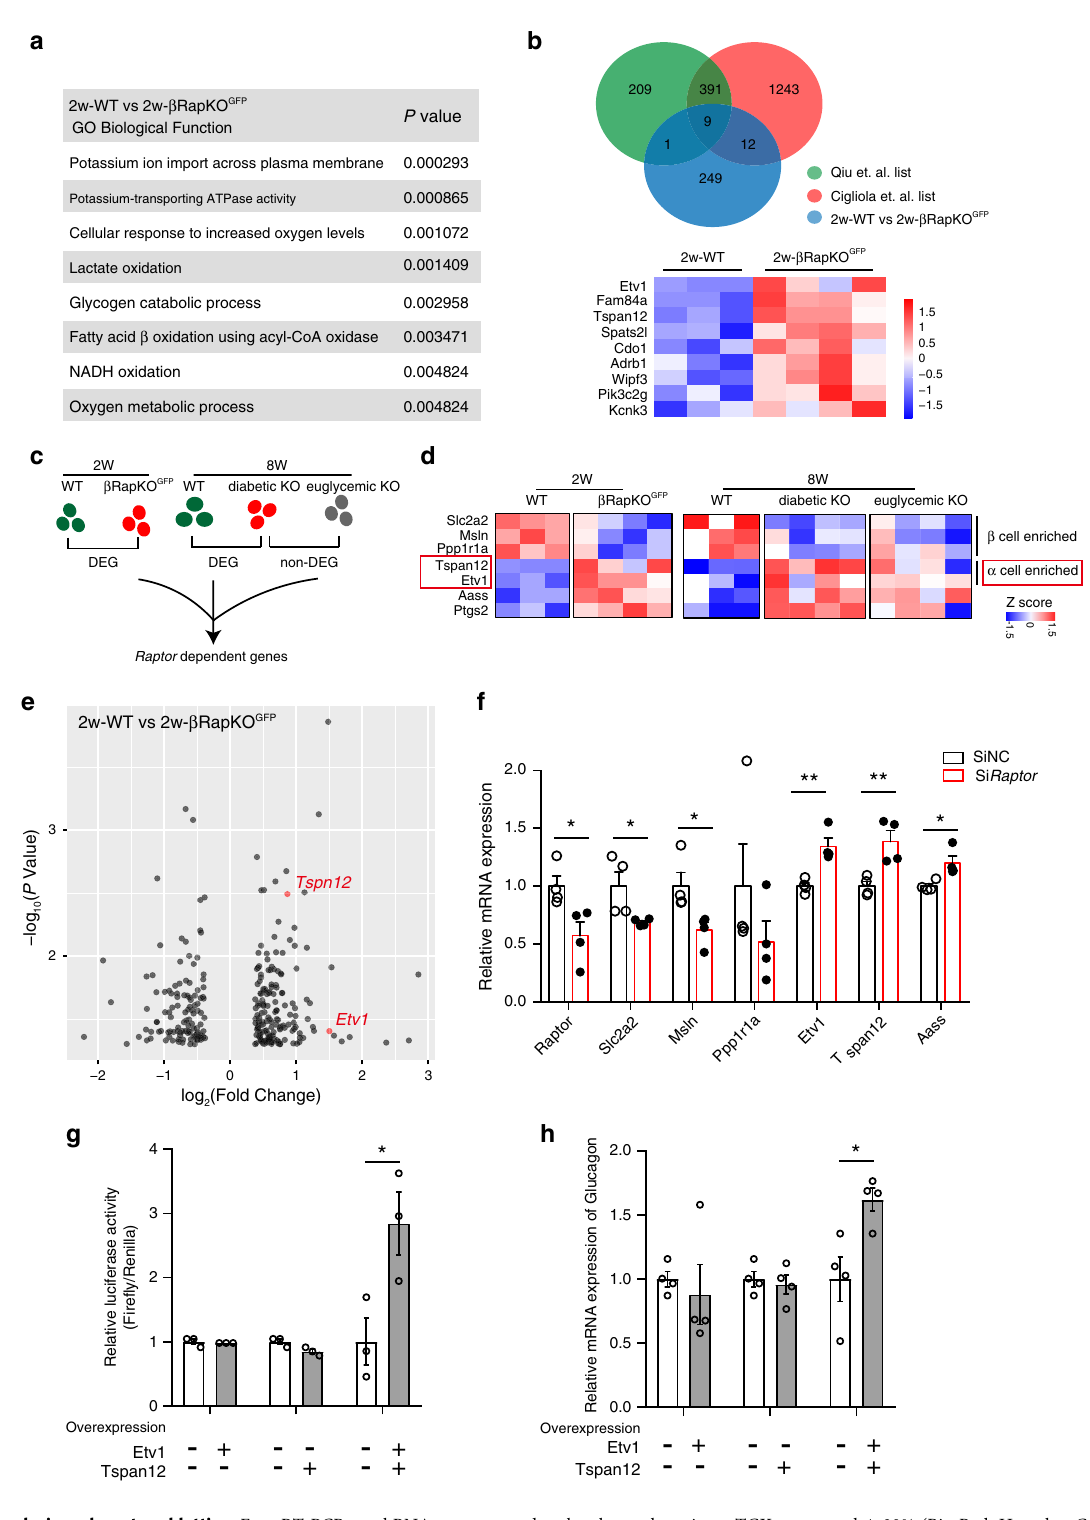
by electrophoresis on TGX precast gel 4 – 20% (Bio-Rad, Hercules, CA, USA) and transferred to a polyvinylidene fl uoride (PVDF) membrane. Primary antibodies are listed as follows: rabbit anti-RAPTOR (1:1000; Cell Signaling Technology, USA), rabbit anti-PS6 (Ser240/244) (1:1000; Cell Signaling Technology, USA), rabbit anti- 4E-BP1 (1:1000; Cell Signaling Technology, USA), rabbit anti-tubulin (1:1000; Cell Signaling Technology, USA), rabbit anti-CPE (1:1000; GeneTex, USA), and guinea pig polyclonal anti-insulin antibody from Liuming Lab 69 . TUBULIN was used as an internal control to normalized band intensity. Horseradish peroxidase-coupled goat-anti-rabbit IgG (1:2000; Cell Signaling Technology, USA) and horseradish peroxidase-coupled goat-anti-guinea pig IgG (1:2000; Jackson ImmunoResearch, USA) were used as a secondary antibody. Blots were developed with